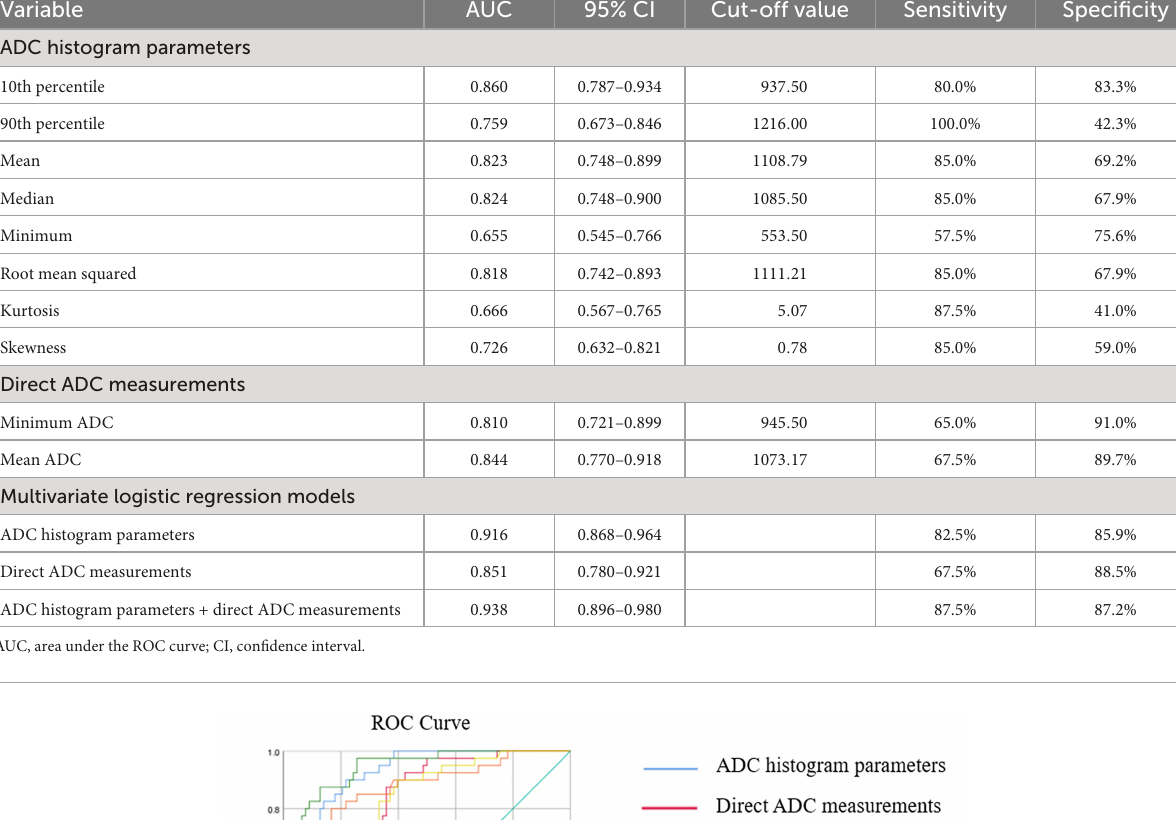
TABLE 3 The diagnostic performances of ADC histogram parameters that were statistically different between IDHmut/MGMTmet and the other glioma group, minimum ADC and mean ADC of direct measurements and multivariate logistic regression models.